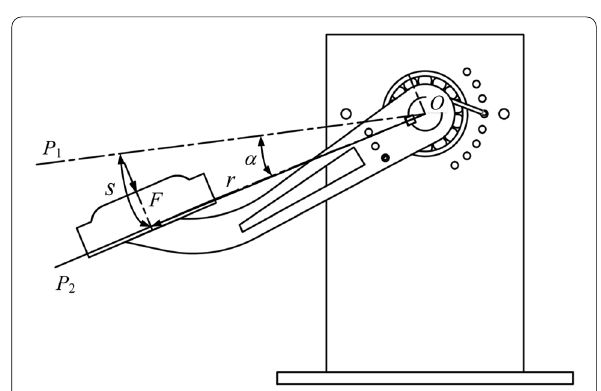
Figure 2 Force diagram of the brake